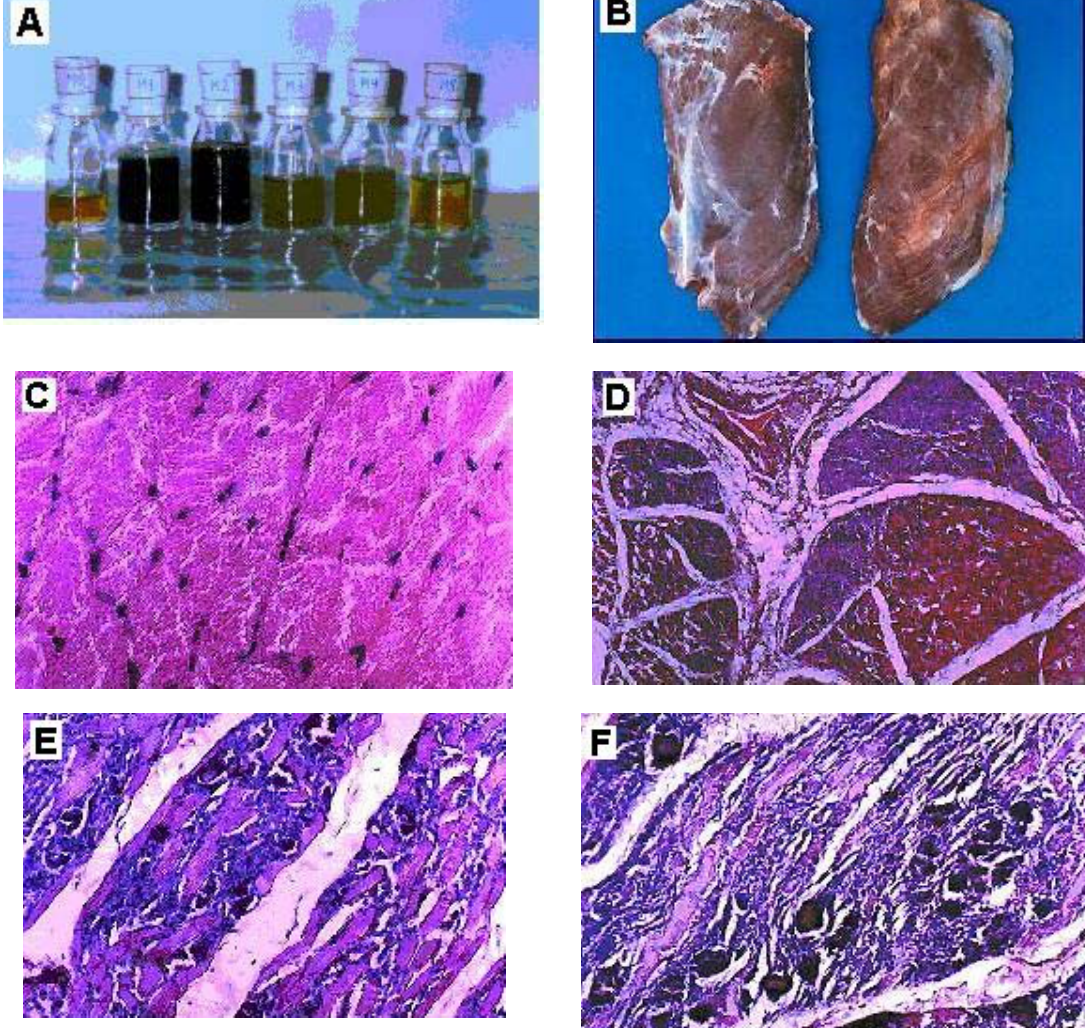
Figure 1. A. Urine color in Group II at control moment, 6h after venom administration (AV), 24h AV, 48h AV, 72h AV, 144h AV. B. Musculature of an animal of a control group showing normal coloration, and musculature of an animal of Group I showing focal whitish areas. C. Transversal section showing integrity of the muscle fiber (HE, 400X). D. Transition between the intact musculature and an extensive area of myonecrosis in the biceps femoris muscle (HE, 50X). E. Longitudinal section of muscle fibers showing necrosis and edema between fibers (HE, 100X).